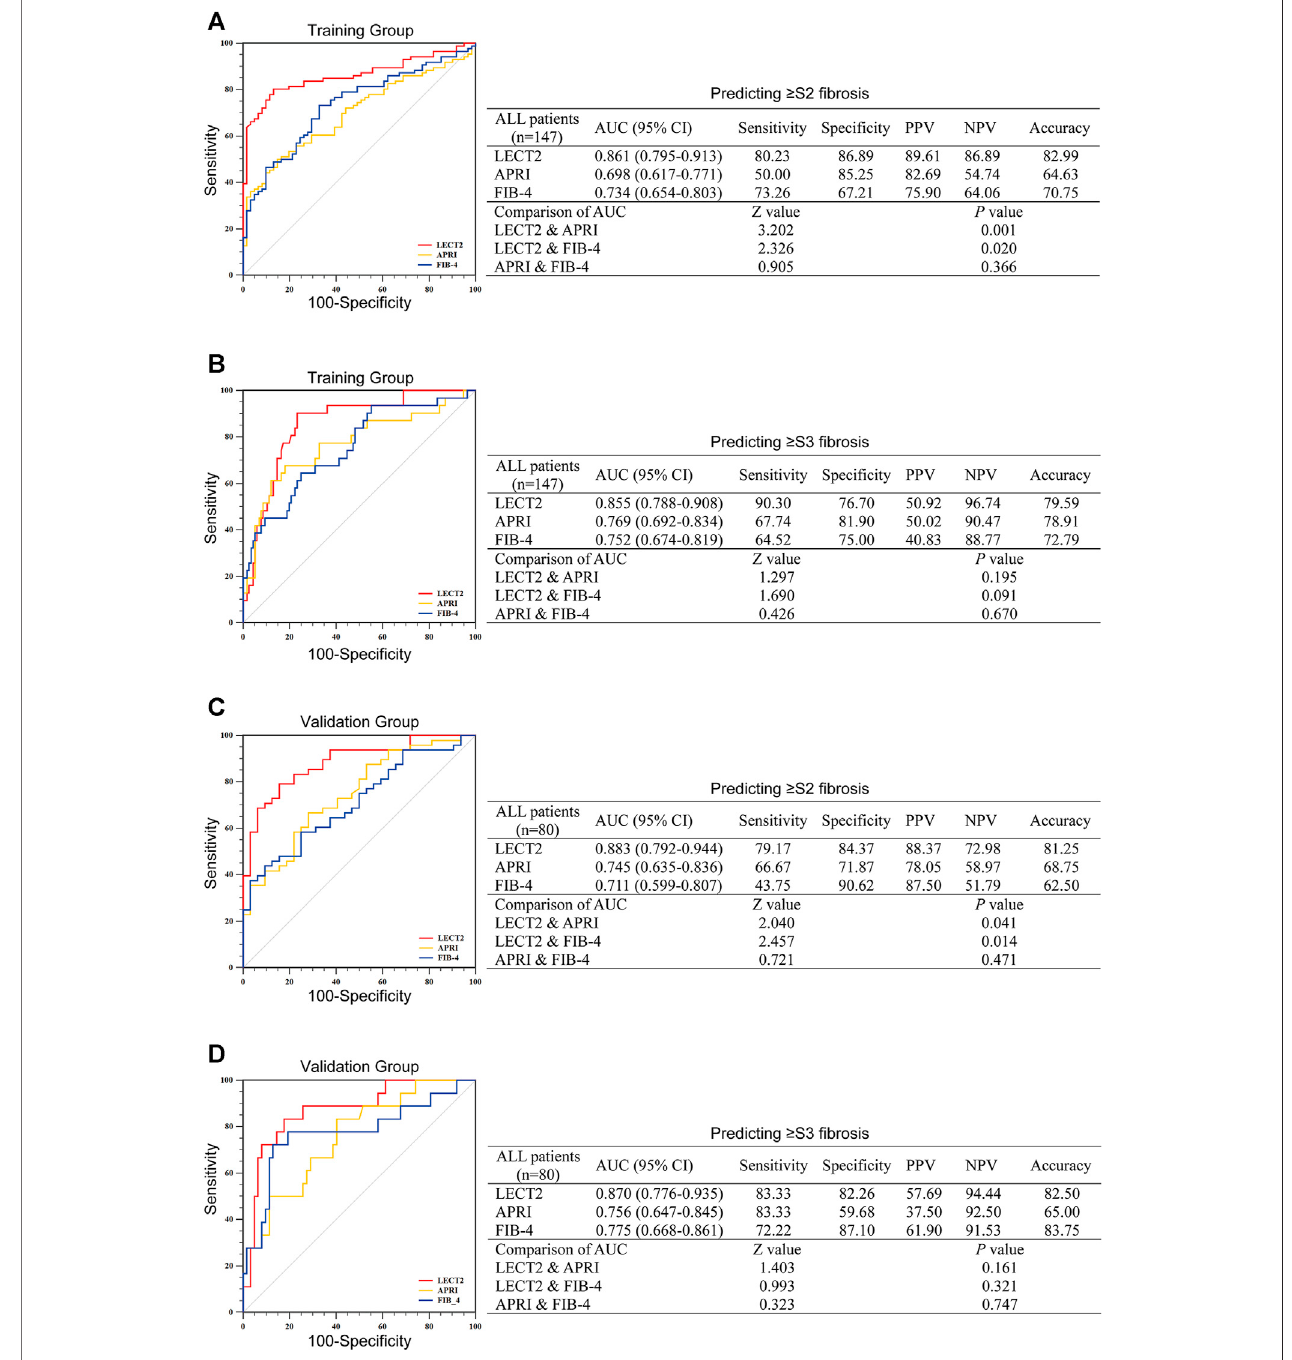
FIGURE 2 | The diagnostic ef fi cacy of LECT2, APRI, and FIB-4 for identifying liver fi brosis in all CHB patients. (A,B) Identi fi cation of signi fi cant liver fi brosis ( ≥ S2) or advanced liver fi brosis ( ≥ S3) in the training group. (C) and (D) show the further veri fi cation of the validation group to the training group. AUC, the area under the ROC; PPV, positive predictive value; NPV, negative predictive